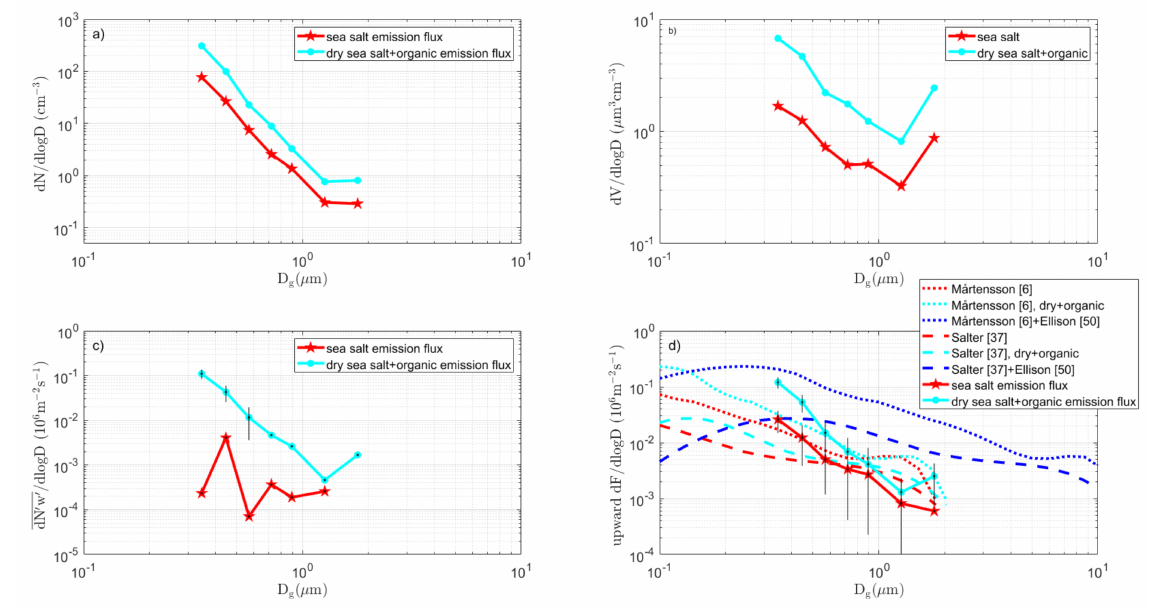
Figure 7. As in Figure 6, except the graphs are for the long fetch sector (145–205 ◦ ).